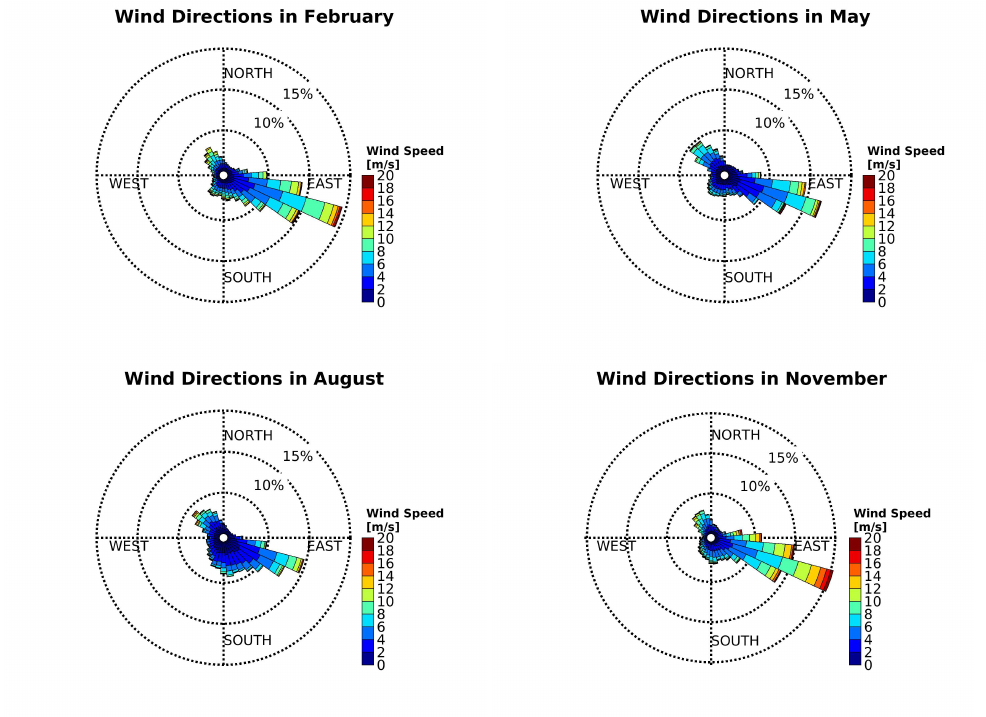
Figure 5. Wind roses at 500 m altitude in February ( top , left ), May ( top , right ), August ( bottom , left ) and November ( bottom , right ) of the years 2013–2021.